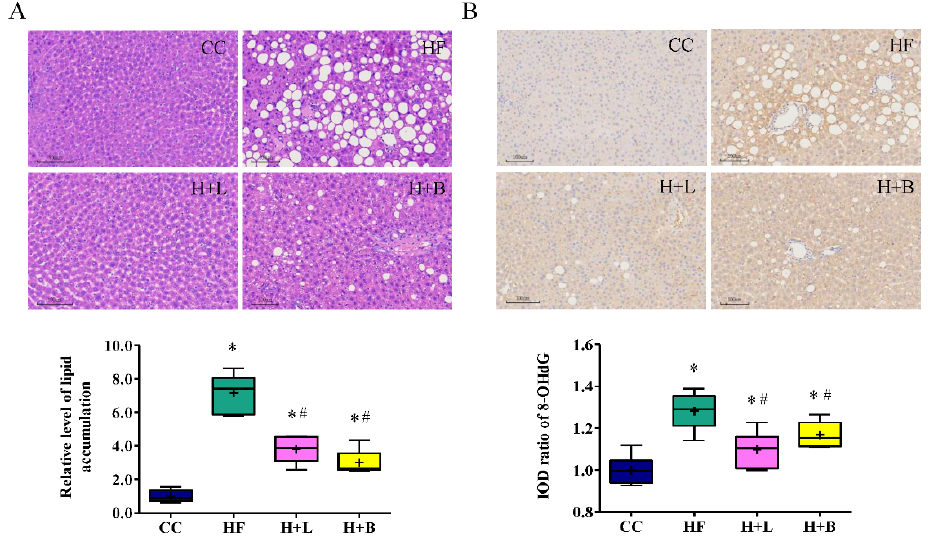
Figure 3. Histological manifestations of dam livers with high-fat diets and Lactobacillus reuteri or sodium butyrate treatment. ( A ) The degree of hepatic steatosis increased with a high-fat diet (HF) and presented as a vacuolation increase via hematoxylin and eosin (H&E) stain. High-fat diet intake caused obvious macrovesicular steatosis (a single lipid droplet filled the entire cell with the displaced nucleus) and microvesicular steatosis (several small cytoplasmic vacuoles with a centrally placed nucleus). L. reuteri treatment during pregnancy (H + L) substantially improved hepatic macrovesicular steatosis and microvesicular steatosis of dams. Sodium butyrate treatment during pregnancy (H + B) mainly improved macrovesicular steatosis and had less effect on microvesicular steatosis. ( B ) Hepatic oxidative stress of dams determined by 8-hydroxy-2-deoxyguanosine (8-OHdG) staining. The liver oxidative stress of dams is highest in the HF group. Both L. reuteri and butyrate therapies during pregnancy improved hepatic oxidative stress related to a high-fat diet. * Compared to the control diet (CC) group, p < 0.05; # compared to the HF group, p < 0.05. IOD, image optical density. The diagram shows the mean level (cross symbol) “+”.